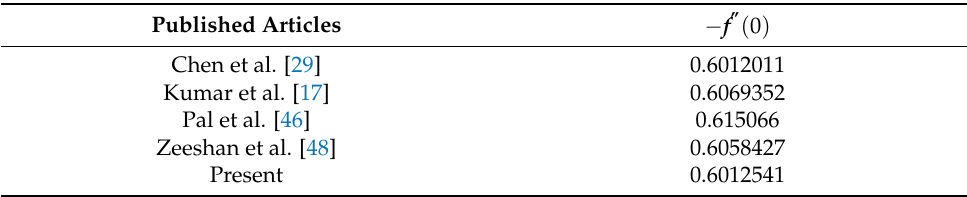
Table 5. Comparison of − f (cid:48)(cid:48) ( 0 ) with available published work by suppressing the